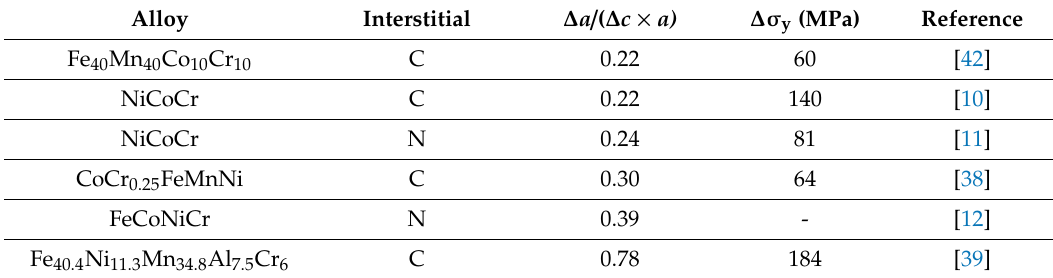
Table 4. Lattice strain, ∆ a / ( ∆ c × a ), and yield strength increase, ∆ σ y , per atomic percent of various interstitials in di ff erent alloys from the references